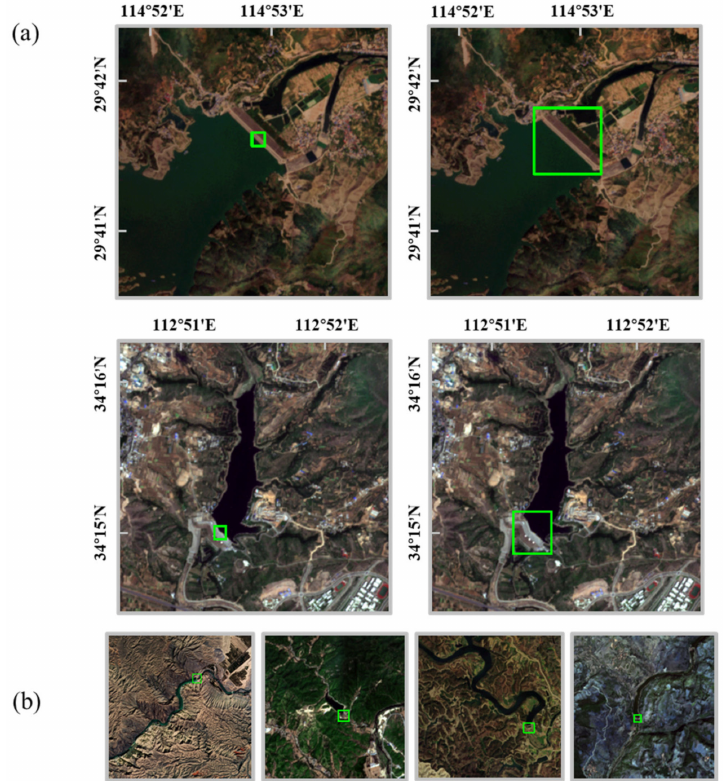
Figure 5. Examples of annotations in our constructed dataset: ( a ) refinement process of the large and medium-sized reservoirs and dams; ( b ) annotations added for small reservoirs and